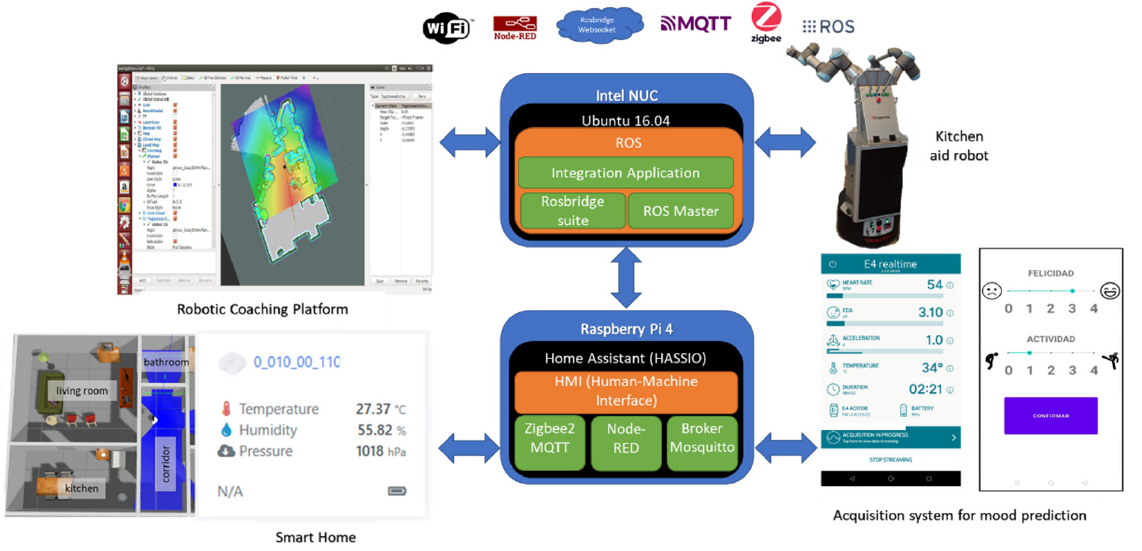
Figure 9. General integration scheme.